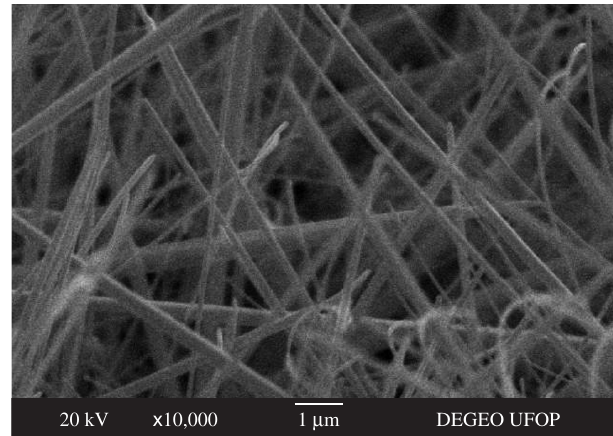
Figure 2. SEM micrographs of the mullite derived from the decomposition of colorless topaz heated at 1340 °C during 3 hours. The needle-type micro- structure is observed as a fiber network ( x